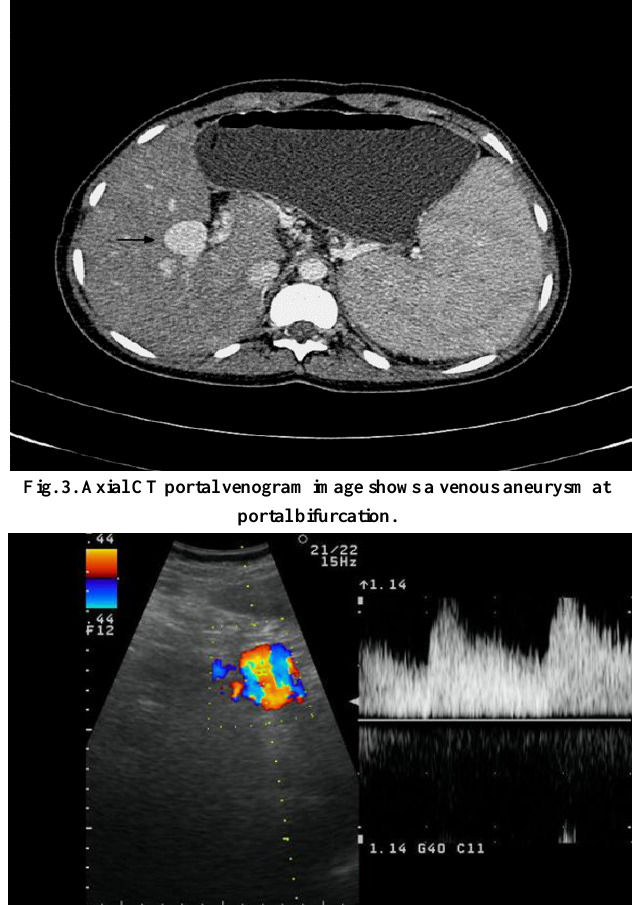
Fig. 2. Axial CT portal venogram scan in a patient with extrahepatic portal hypertension shows replacement of the entire portosplenic venous axis by multiple peripancreatic collaterals ( ← ) and portal cavernoma formation.